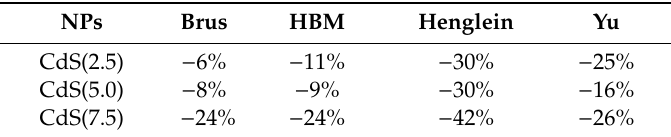
Figure 12. Comparison among the nanoparticles’ size obtained with the theoretical methods studied in this paper and the experimental values obtained with TEM images (solid lines). Table 3. Results’ deviation between the different theoretical models estimation for the size and the real measurements obtained with TEM analysis.